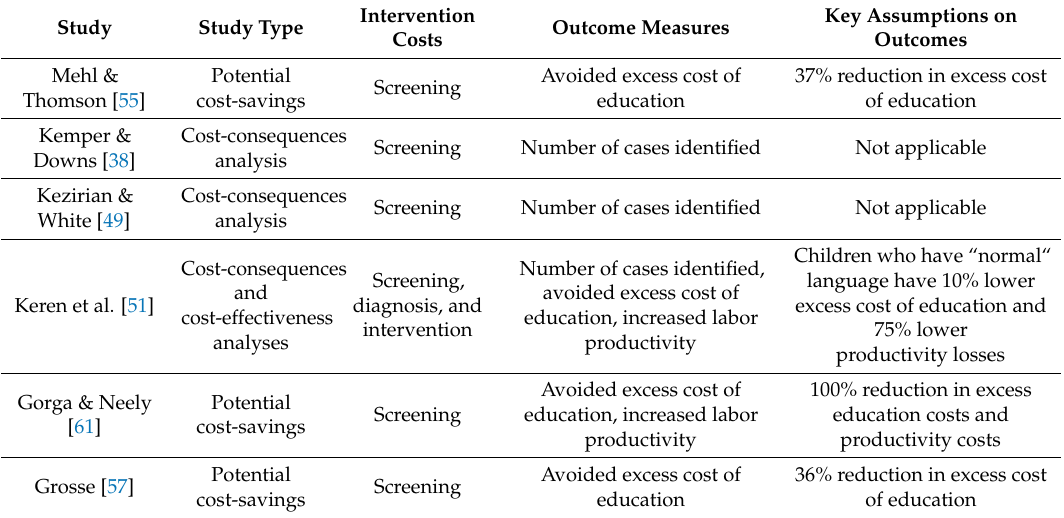
Table 3. Published partial or full US economic evaluations of UNHS/EHDI policies or